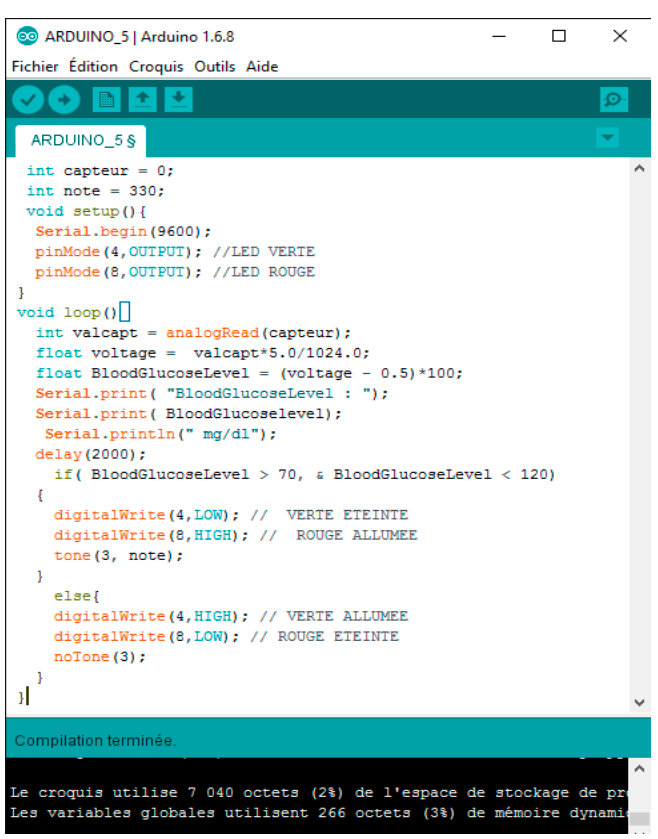
Figure 8. Coding for the reading of the sensor.